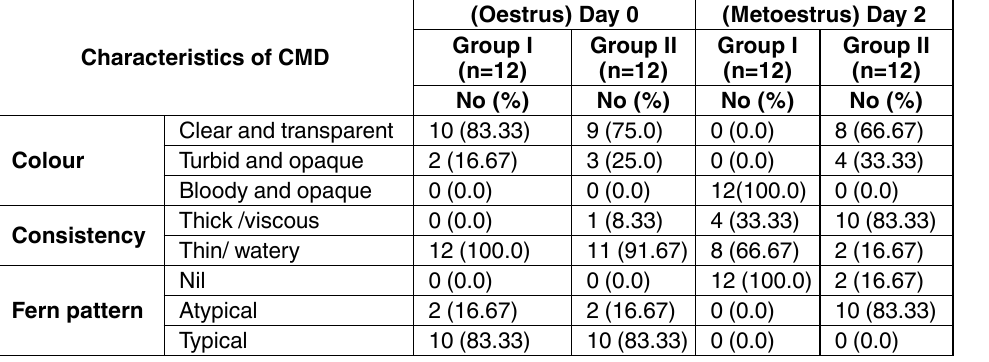
table 1. Colour and consistency of cervical mucus discharge during oestrus and metoestrus in cows with and without metoestrual